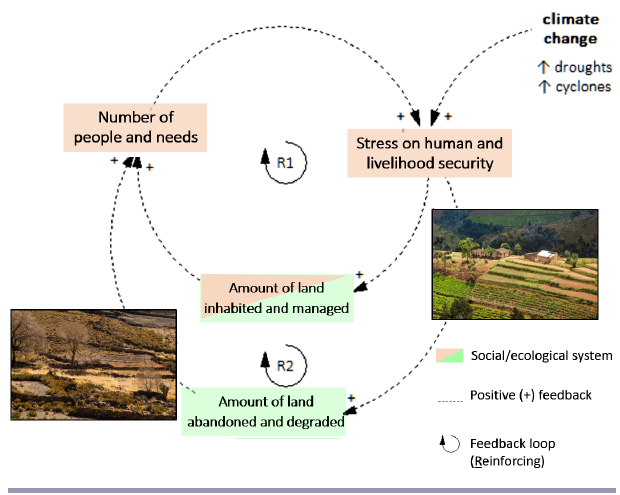
Fig. 3 . Causal loop diagram for human migration in coastal areas of the Pacific Ocean driven by the impacts of climate change, among other factors. R = reinforcing feedback loop, in which changes are exacerbated and result in even more changes in the